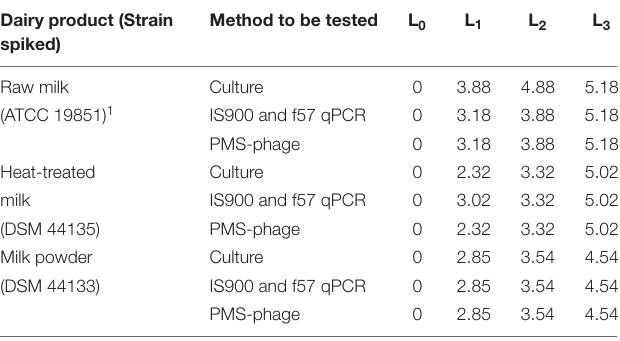
TABLE 5 | Estimation of the MAP spiking levels L 0 , L 1 , L 2 , and L 3 in milk test portions prepared for the LOD study by MPN technique expressed in log MPN/50 ml.